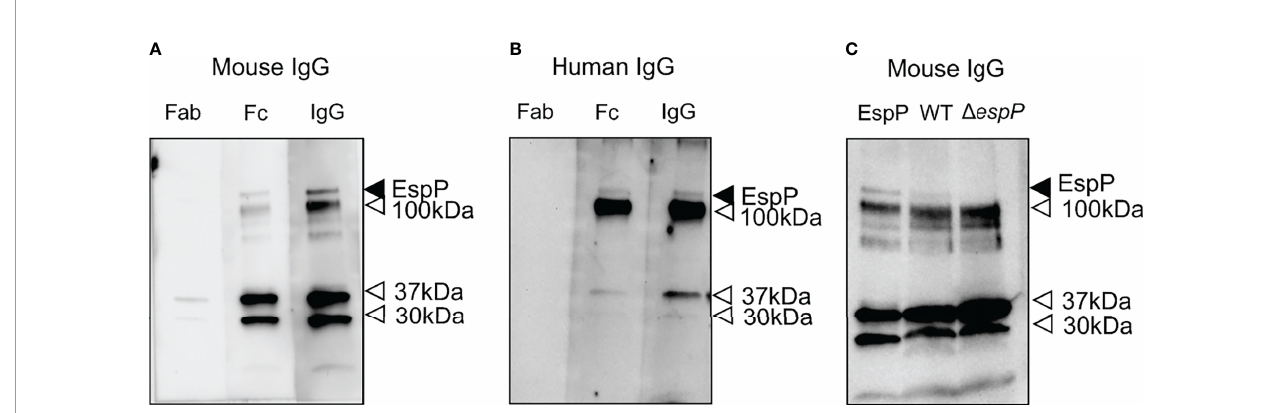
EspP, Extracellular serine protease P. a ExtractedproteinsfromE.coliO157:H7culture fi ltratesboundtoIgGandcutoutfromamembrane.Sevenbandswereidenti fi edcorrespondingtocolumns1-7( Figure5C ).Proteinsare shown if peptide sequences from the same protein were identi fi ed in more than one column. b Extracted proteins from E. coli O157:H7 culture fi ltrates detected with both mouse and human IgG. c Extracted proteins from E. coli O157:H7 culture fi ltrates detected with only human